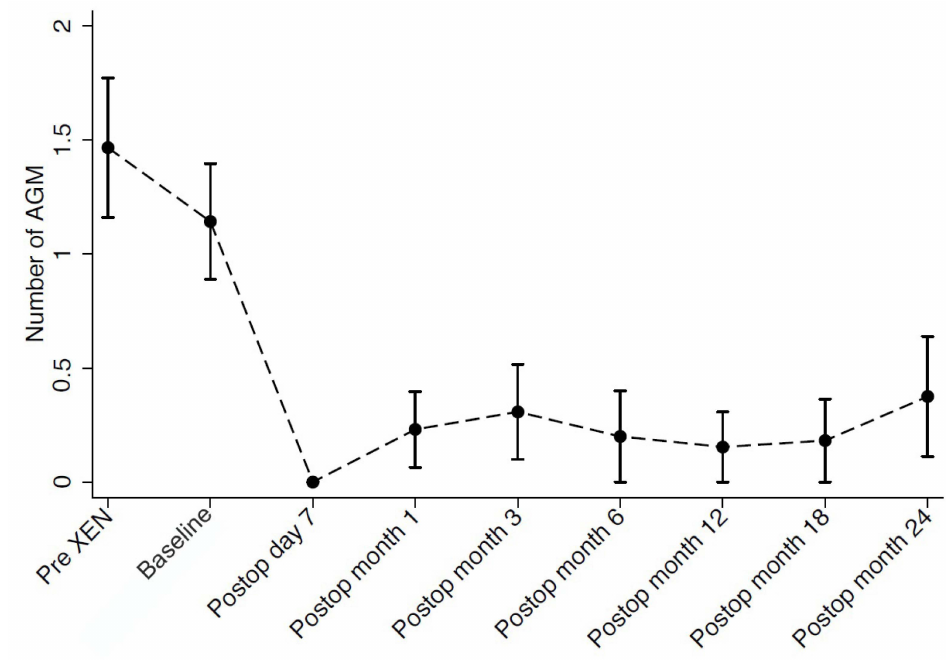
Figure 2. Graph showing the number of antiglaucoma medications (AGM) through 24 months of follow-up.